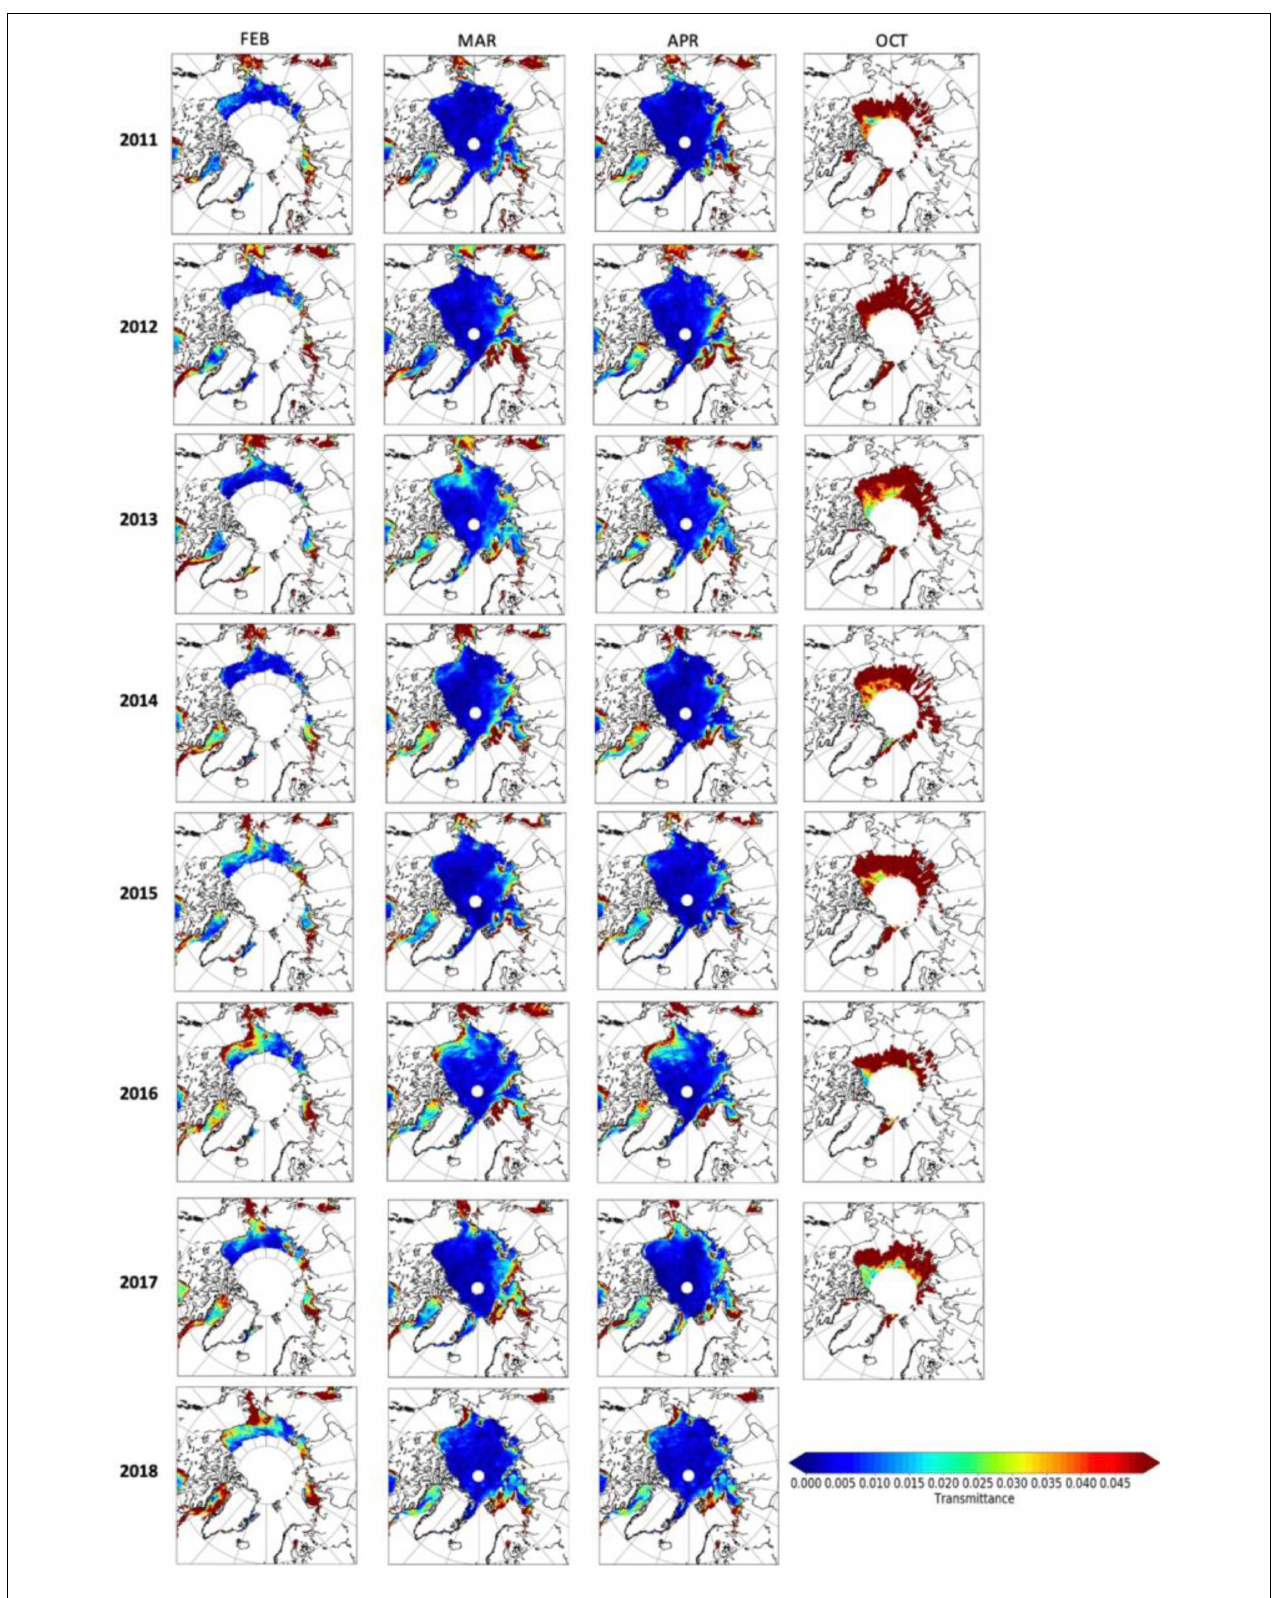
FIGURE 4 | Summary of the monthly mean transmittance produced using the satellite-derived sea ice and modeled snow depth data for all months and all years from February 2011 to April 2018.